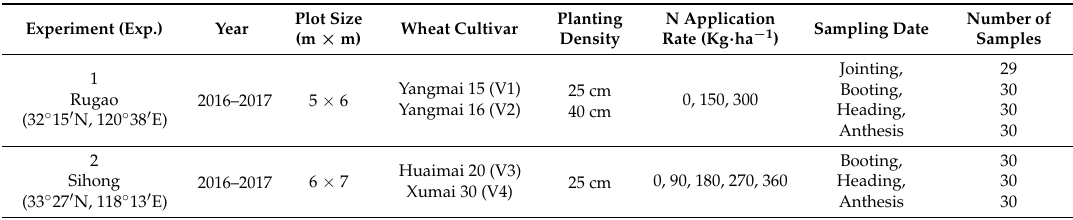
Table 1. Design of two field experiments and data